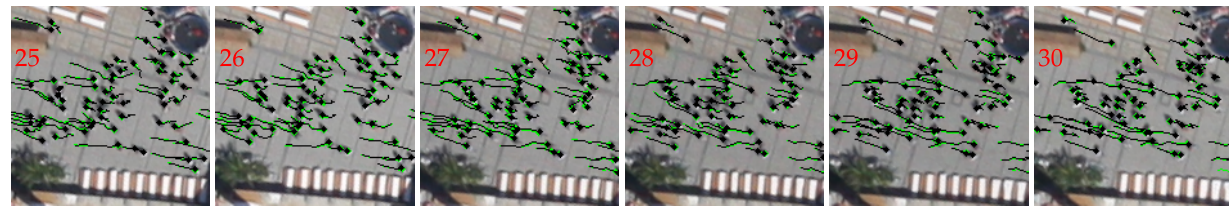
Figure 7. A success case processed by Stacked-DCFNet on the sequence “Munich02”. The tracking results and ground truth are depicted in green and black,